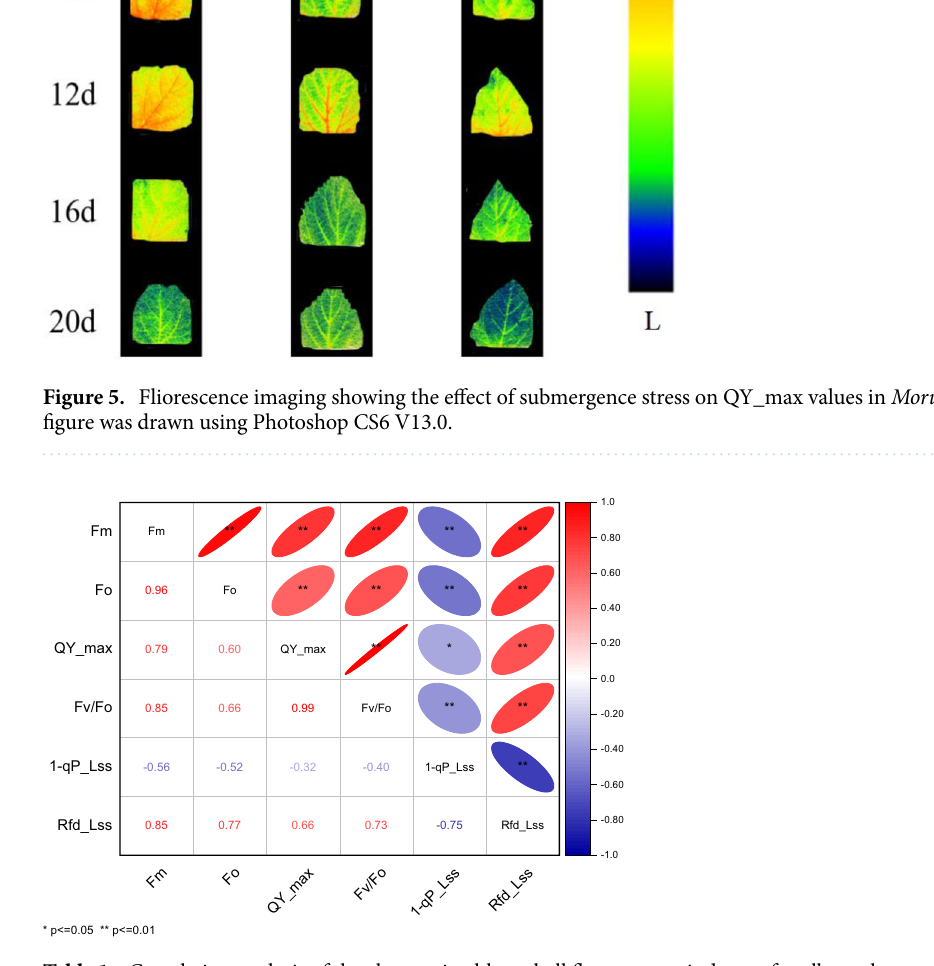
Table 1. Correlation analysis of the changes in chlorophyll fluorescence indexes of mulberry leaves under different waterlogging treatments. This table was drawn using Origin Pro 2021 v.